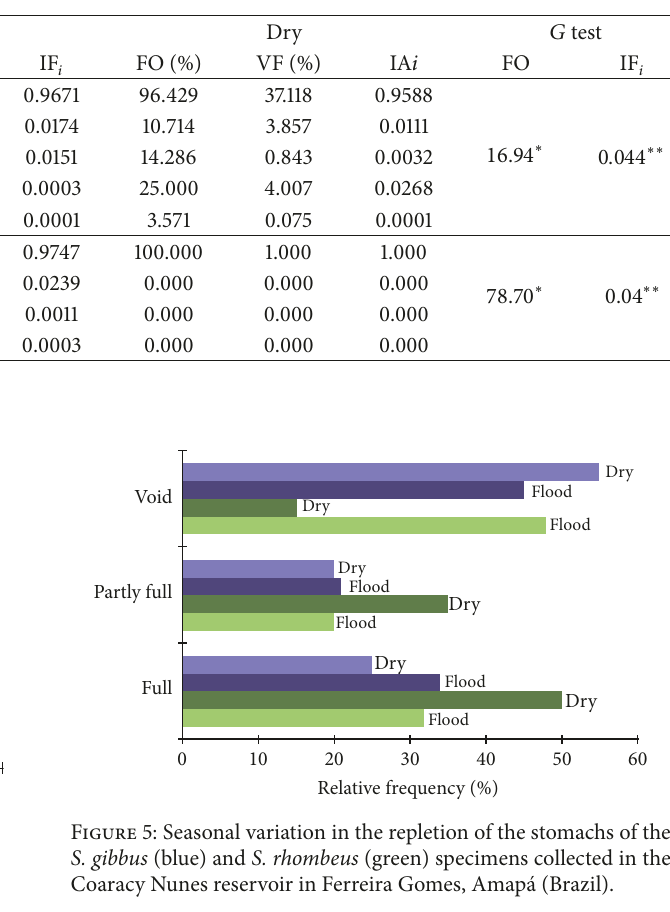
Table 1: Frequency of occurrence (FO), volumetric frequency (VF), and index of feeding importance (IF 𝑖 ) of the items encountered in the stomach contents of the S. gibbus and S. rhombeus specimens captured in the dry and flood seasons in the Coaracy Nunes reservoir in Ferreira Gomes, Amap´a (Brazil).